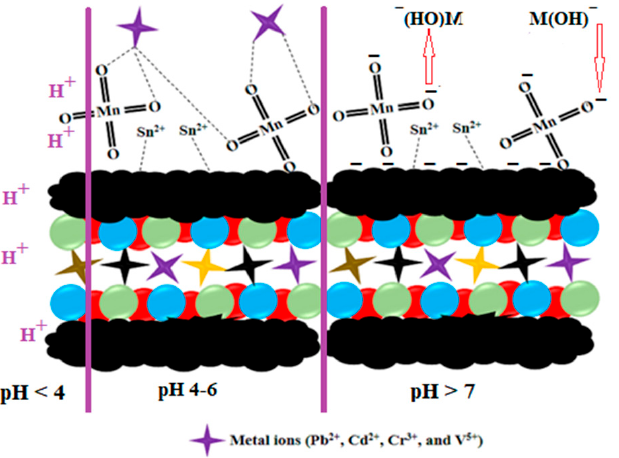
Figure 11. Schematic of the proposed mechanism for heavy metal ion removal by AC-SML.